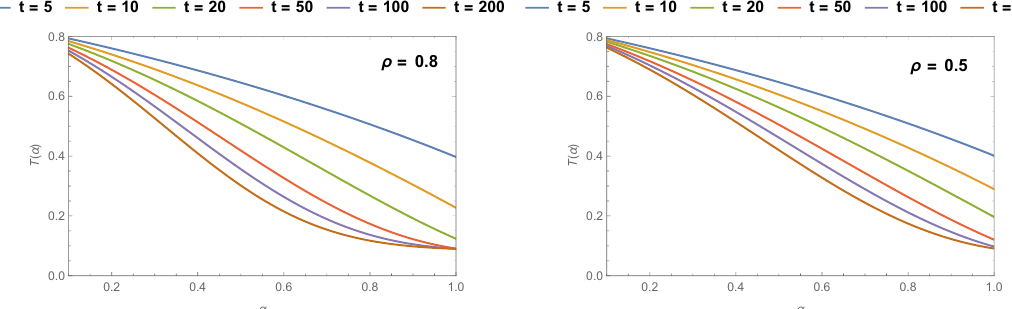
Figure 7. Comparison of drying kinetics with Lewis generalized fractional model under different α orders and ρ values.